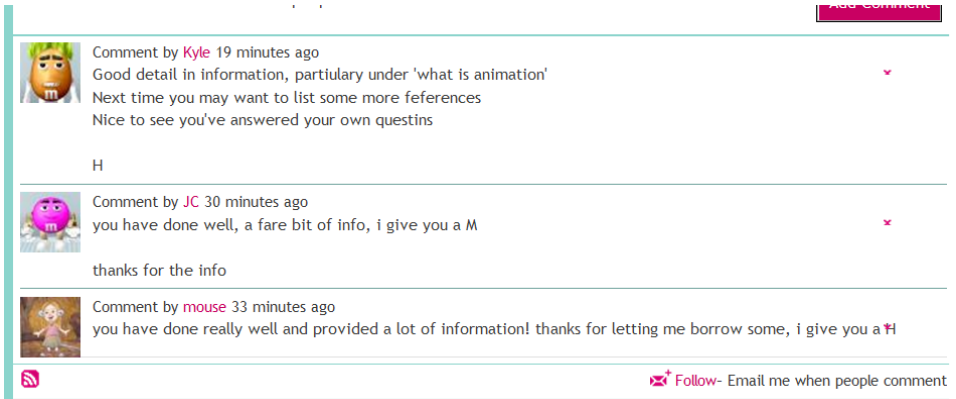
Figure 7. Screen clip showing student feedback and assessment, as well as appreciation from the user “mouse,” who thanks another student for sharing information.